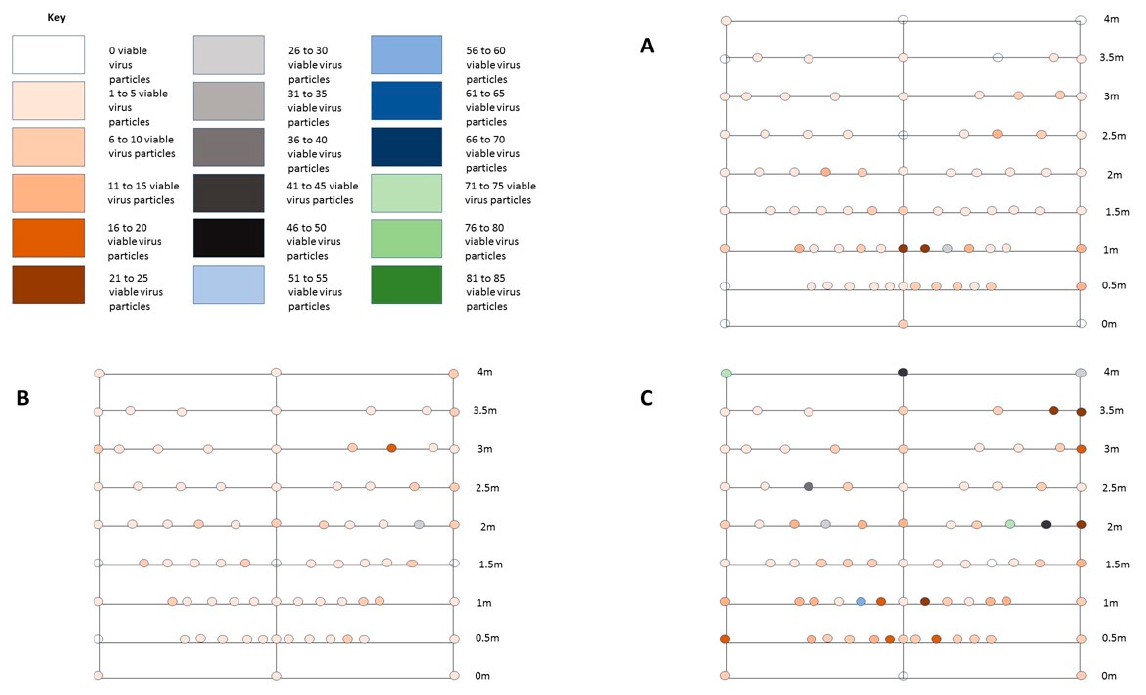
Figure 6. ( A – C ) Average environmental spread of cough (based on 3 tests) with no intervention (test A ), cough with a hand cupped in front of the mouth (test B ) and cough with inner elbow in front of the mouth (test C ). All data points = average of three test